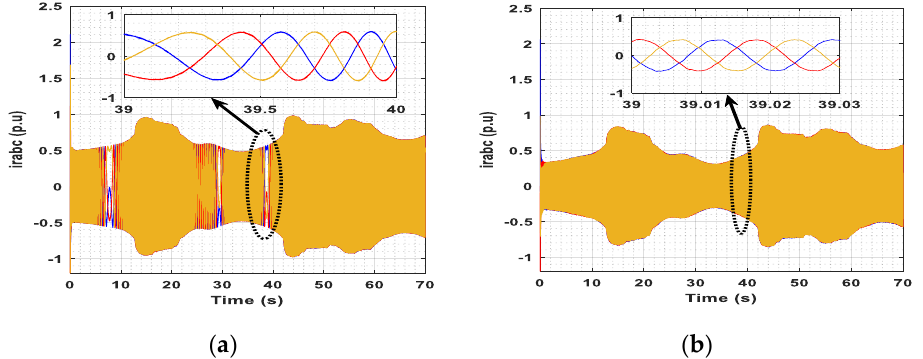
Figure 13. ( a ) Rotor current, ( b ) stator current waveforms under SMC.